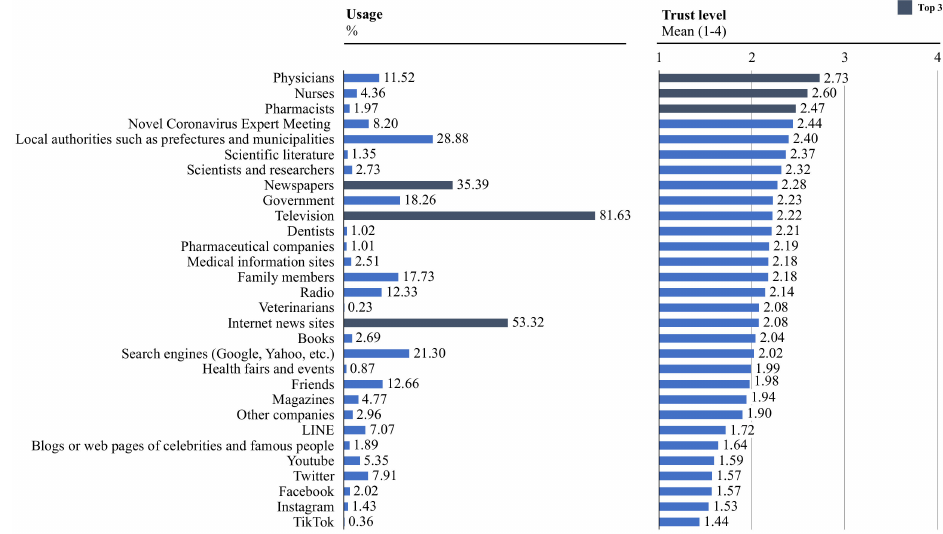
Figure 1. Use and trust levels of COVID-19 information sources ( n = 30,000).